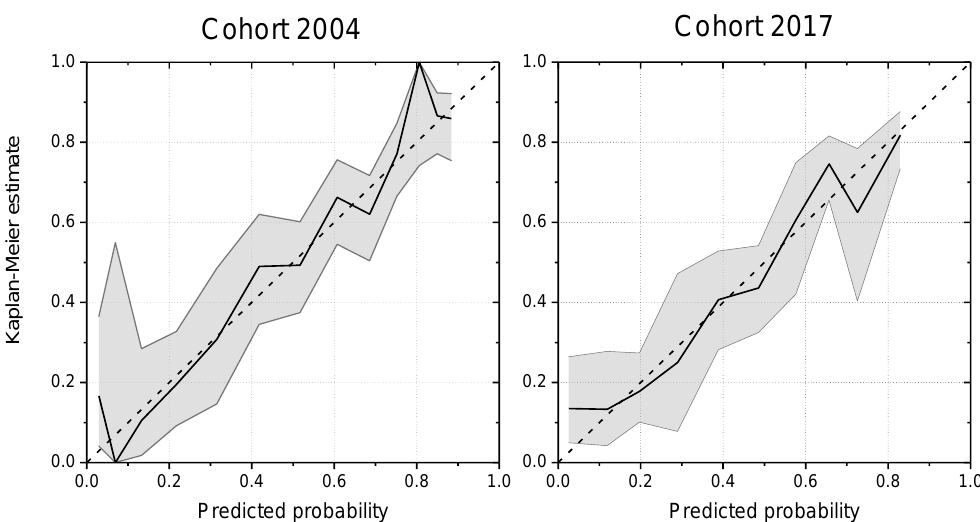
Figure 2. Calibrations plots with 95% confidence intervals for the breastfeeding scores in the validation cohorts 2004 ( n = 633) and 2017 ( n = 579). Table 3. Primiparous and multiparous mothers in the validation cohorts divided into risk groups according to their breastfeeding scores. Numbers and proportions of mothers who stopped breastfeeding within 17 weeks in each risk group.